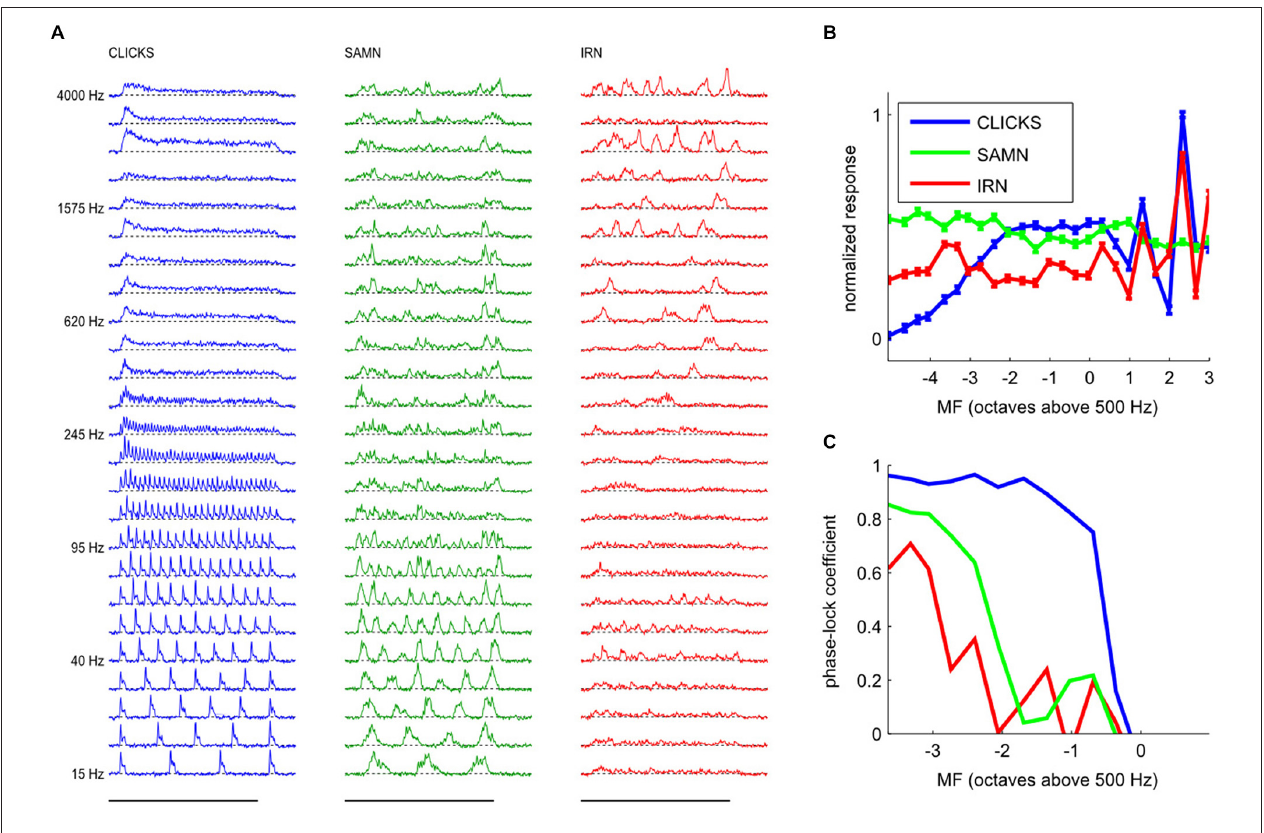
data shown in (A) by plotting the total response (area under the curves in A ) as a function of stimulus MF. Error bars show standard error of the mean. Standard errors were small, so error bars may be hard to see. It is evident that both the shape and the maxima of the rMTF were strongly stimulus dependent; the rBMFs for this multiunit were 2510 kHz for click trains and IRNs, but only 95 Hz for SAMN. (C) Temporal modulation transfer functions (tMTFs), calculated as described in the “Materials and Methods” Section, for the responses shown in (A)